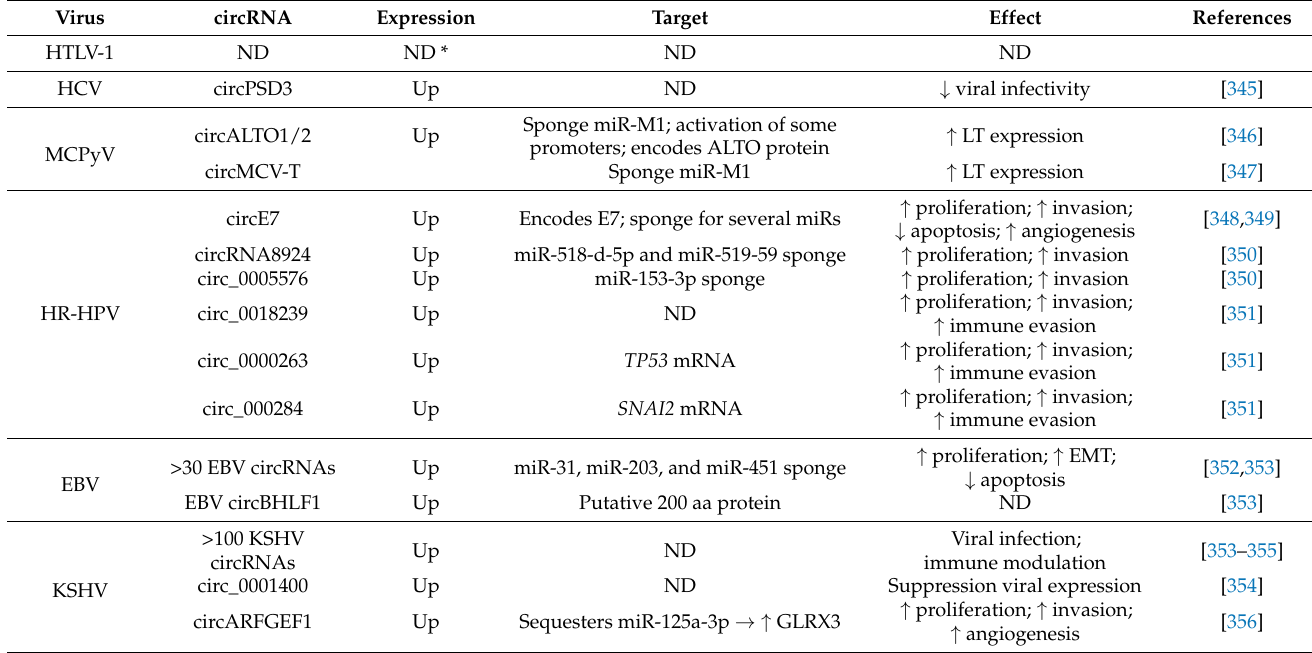
Table 5. Human tumor virus and circular RNAs with their targets and known functions in virus-induced oncogenesis. See text for